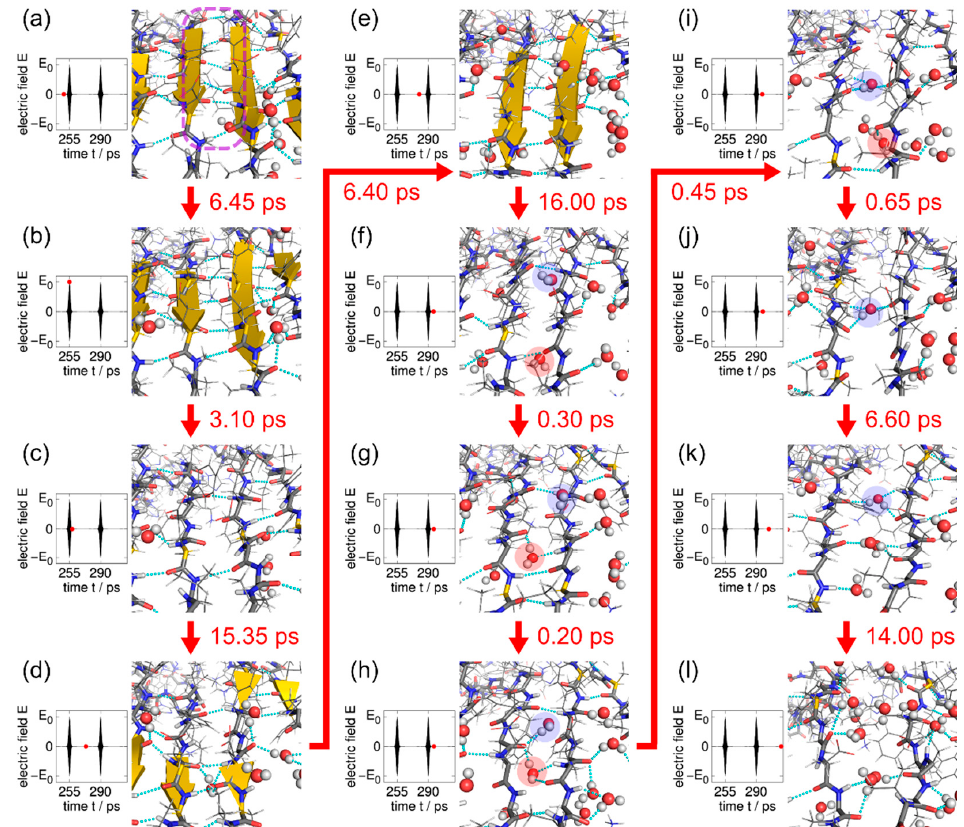
Figure 17. ( a – l ) Disruption process of the hydrogen bonds between the A β peptides and the electric field pulse. Two water molecules that disrupted the hydrogen bond re-formation between the A β peptides are highlighted with pink and blue circles. The images were created using PyMOL [171]. Reprinted with permission from Ref. [84]. Copyright 2021 American Chemical Society.